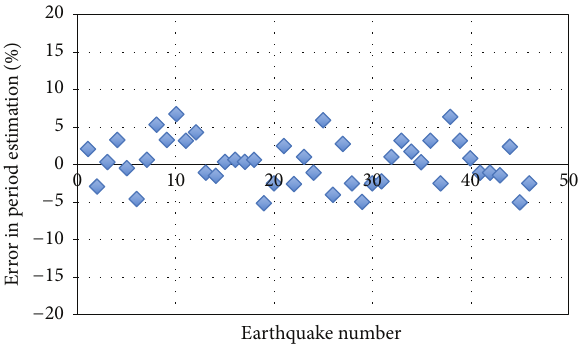
Figure 8: Variation of error in estimation of period for different earthquake responses.